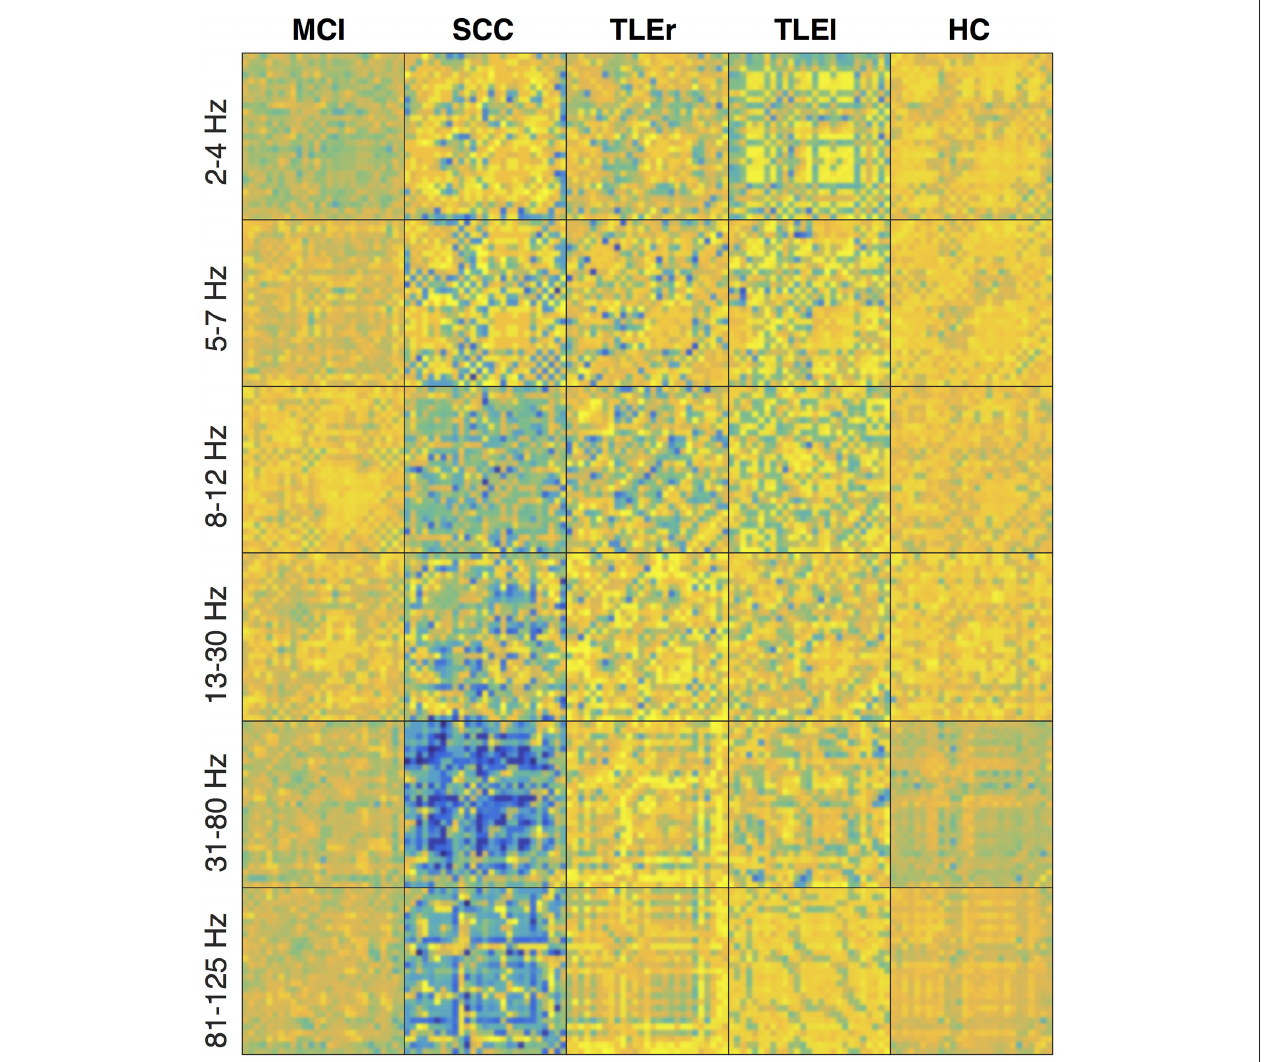
FIGURE 4 | Heatmaps of the reliability of all electrode × electrode interactions for spectrum, sorted by frequency in rows and groups in columns. Colors indicate values from − 1 (dark blue) to + 1 (bright yellow). Electrodes start from top left following the order: F3, F4, C3, C4, P3, P4, O1, O2, F7, F8, T7, T8, P7, P8, Fz, Cz, Pz, FC1, FC2, CP1, CP2, FC5, FC6, CP5, CP6, TP9, and TP10. MCI, mild cognitive impairment; SCC, subjective cognitive complaints; TLEr, right lateralized temporal lobe epilepsy; TLEl, left lateralized temporal lobe epilepsy; HC, healthy